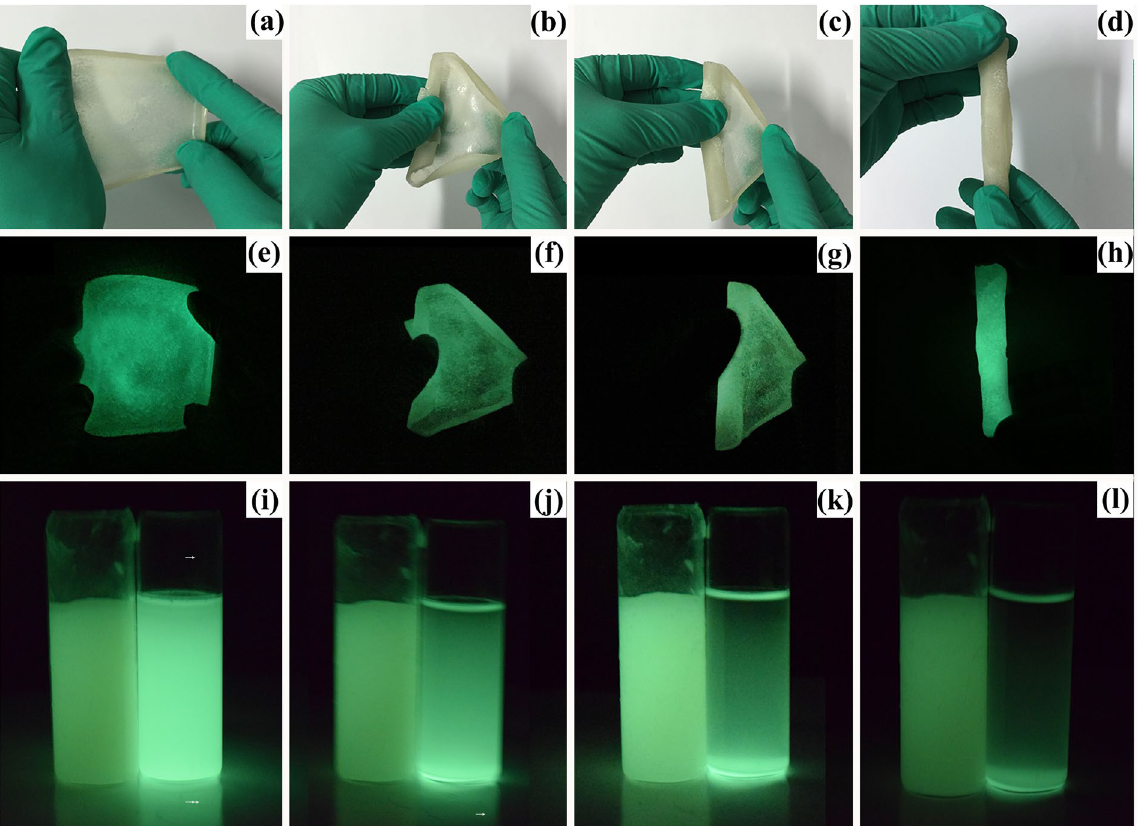
Figure 6. Optical image( a–d ) indicates the high flexibility of hydrogel and optical image, ( e–h ) shows the fluorescence properties of hydrogel. Photographs of 0.32% aqueous solution of phosphorescent Eu 2 + /Dy 3 + doped SrAl 2 O 4 (right) and a water 100 times of hydrogel (left) under sunlight from 0 min ( i ), 5 min ( j ), 20 min ( k ) and 25 min ( l ) after mixing,